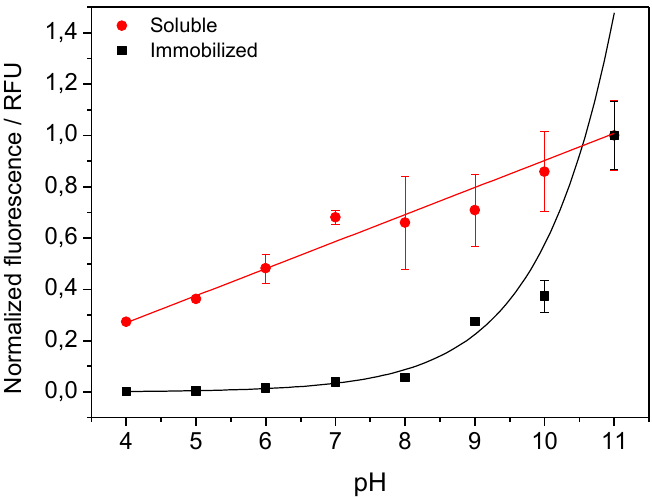
Figure 2. Dynamic range of the fluorescence of soluble and immobilized His-RFP at different pHs. The experimental data of soluble His-RFP were fitted by using a simple linear regression: y = a + b x (a = − 0.15 and b = 0.105). In case of immobilized His-RFP, the experimental data were adjusted to an exponential growth function with constant parameters: y = ab x (where a = 4.6 × 10 − 5 and b = 2.57)